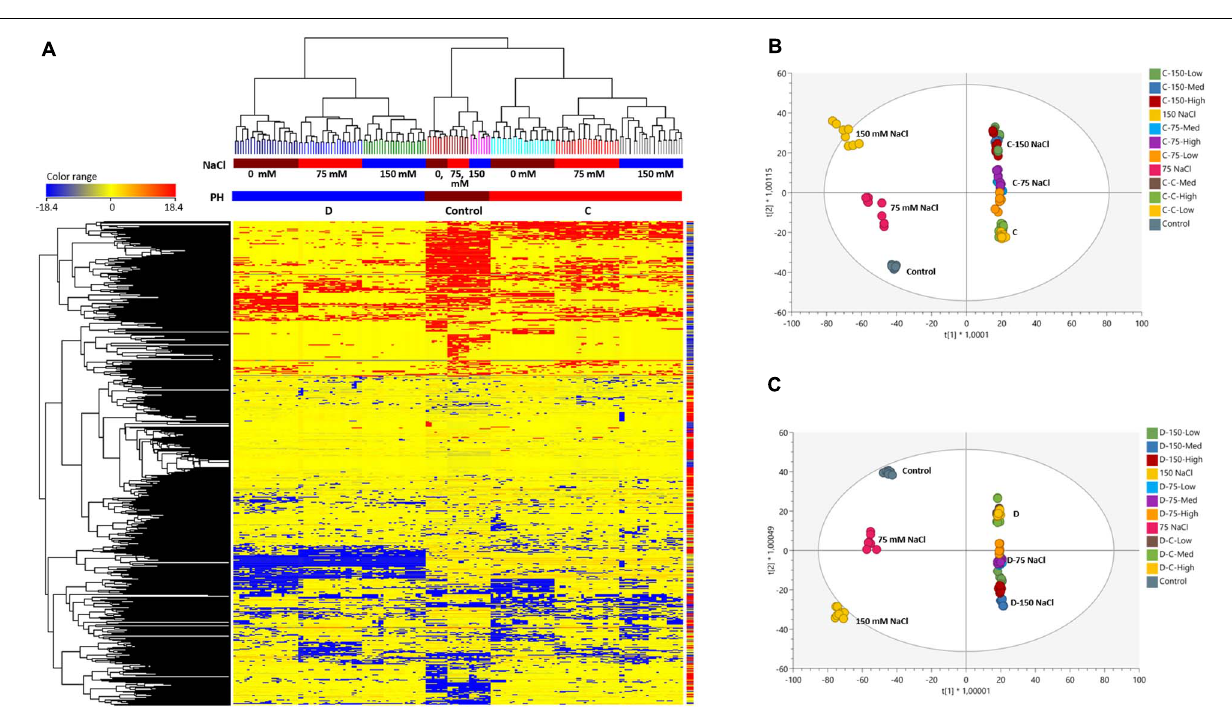
FIGURE 6 | Fold-change based unsupervised hierarchical cluster analysis (Euclidean distance) carried out from metabolomic profile of plants treated either with the biostimulant C or D, at different salinity levels (A) ; OPLS-DA (Orthogonal Projections to Latent Structures Discriminant Analysis) supervised modeling of metabolomic profile in plants at different salinity levels and treated with the OPLS-DA of the two best performing protein hydrolysates, C (B) and D (C)